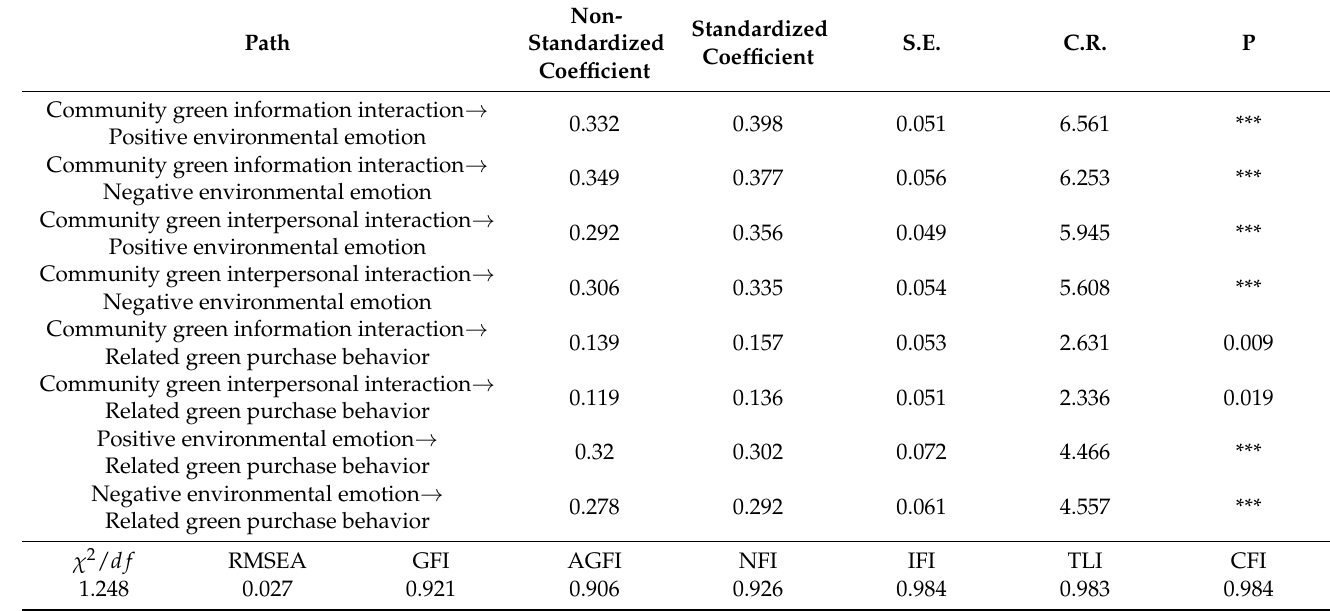
Table 4. Path test results and model fitness